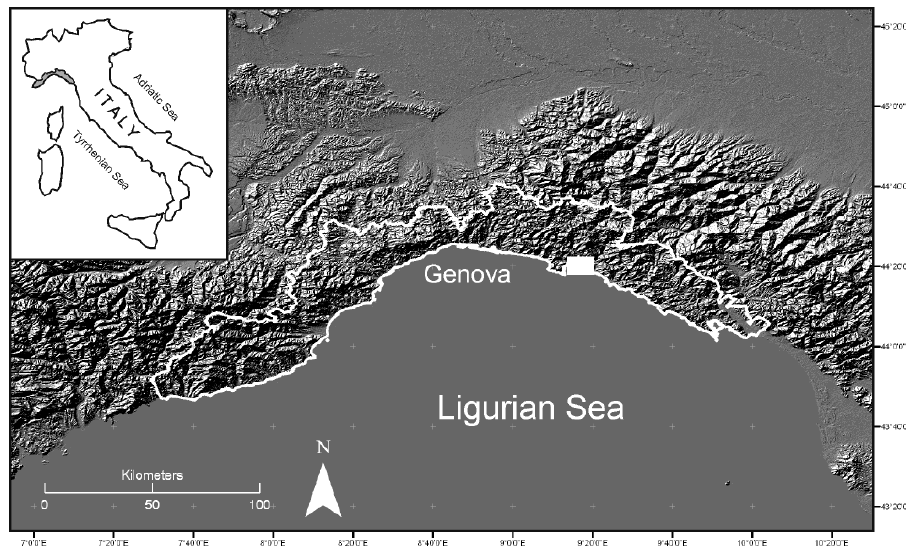
Fig. 1 Fig. 1. Location map of the study